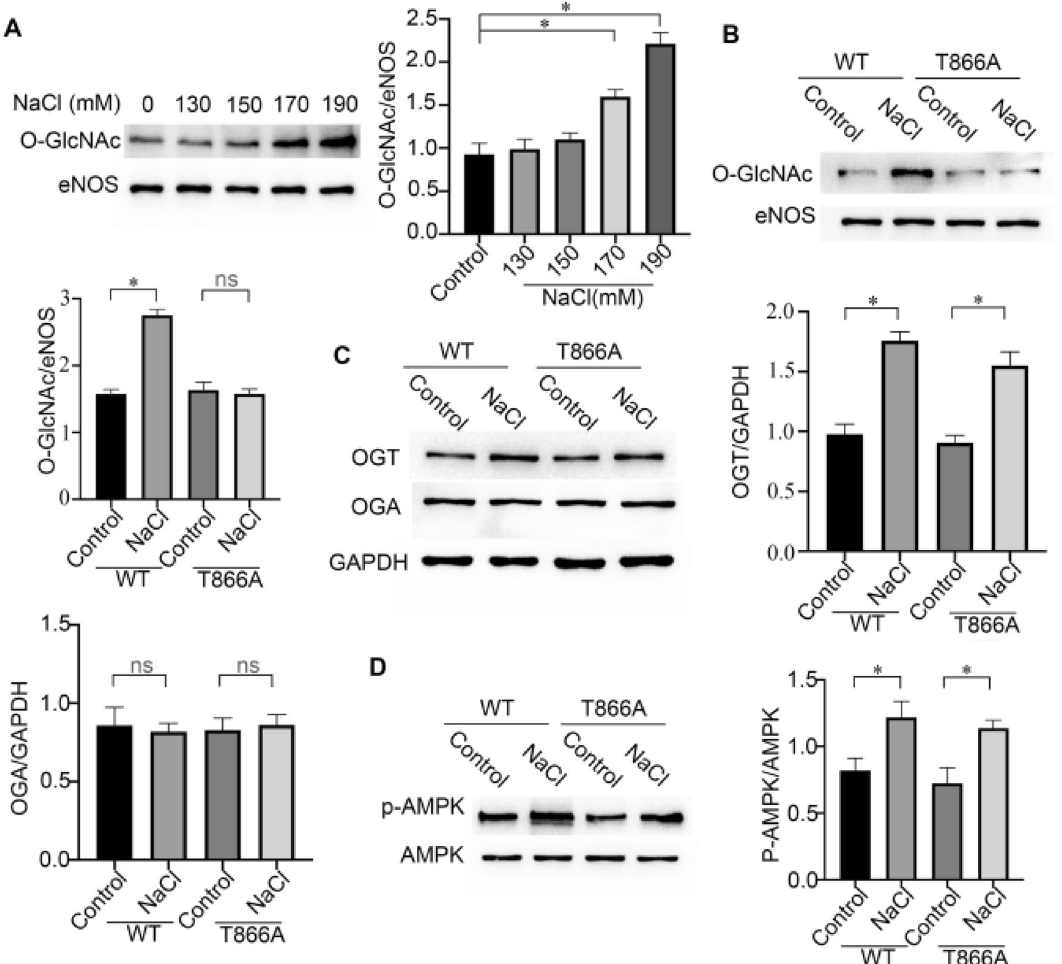
Figure 3. Hypertonic stress causes upregulation of OGT expression and activation of AMPK in cells transfected with His-tagged WT-eNOS or T866A-eNOS. ( A ) Changes in the levels of O-GlcNAc/eNOS in BAECs treated with 110 to 190 mM NaCl. Typical images and statistical graphs are shown, n = 3. ( B ) Changes in the levels of O-GlcNAc/eNOS in BAECs treated with NaCl (190 mM). Typical images and statistical graphs are shown, n = 3. ( C ) Changes in the expression of OGT and OGA in BAECs treated with NaCl (190 mM). Typical images and statistical graphs are shown, n = 3. ( D ) Changes in the ratio of p-AMPK/AMPK in BAECs treated with NaCl (190 mM). Typical images and statistical graphs are shown, Full-length blots are presented in Supplementary Figure S11A, S12B, S13C, S14D. n = 3. *P < 0.05, ns indicates no